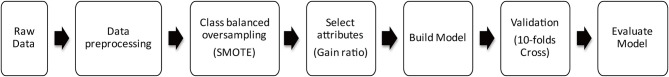
Machine learning method to predict the functional outcome in ICH patients.